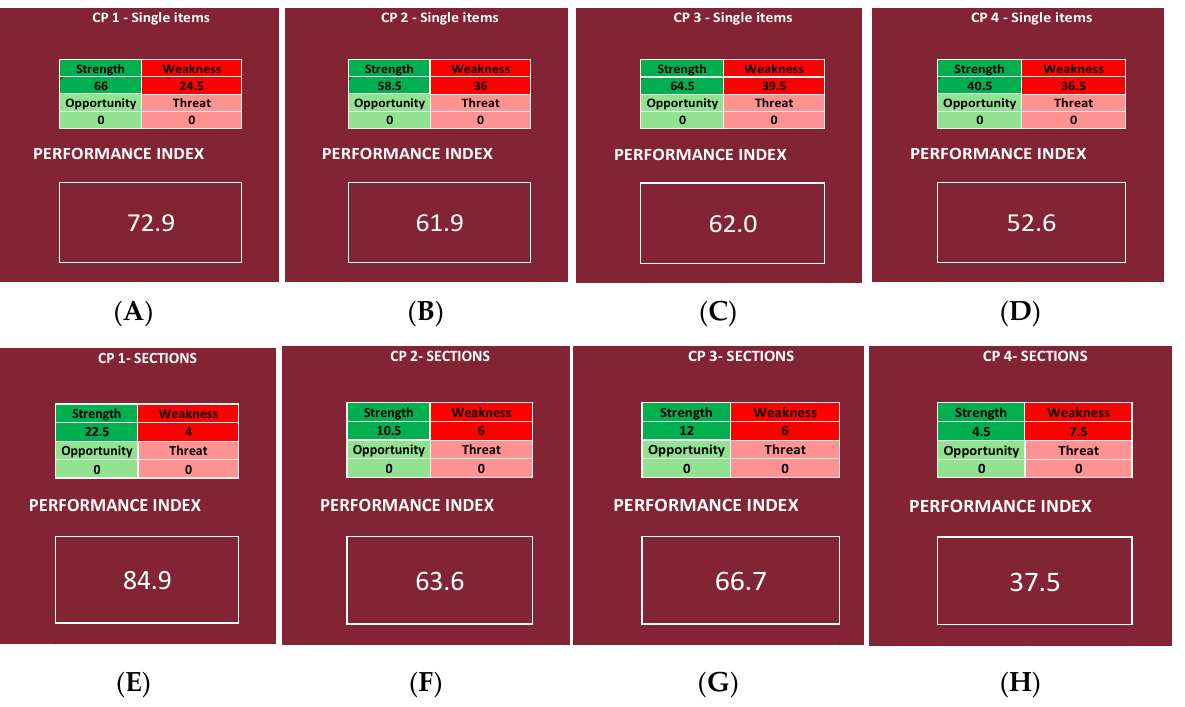
Figure 9. Performance index calculated by using the scores of all four CPs but inserting either the single items ( A ) or only the Questionnaire Sections mean scores ( B ).